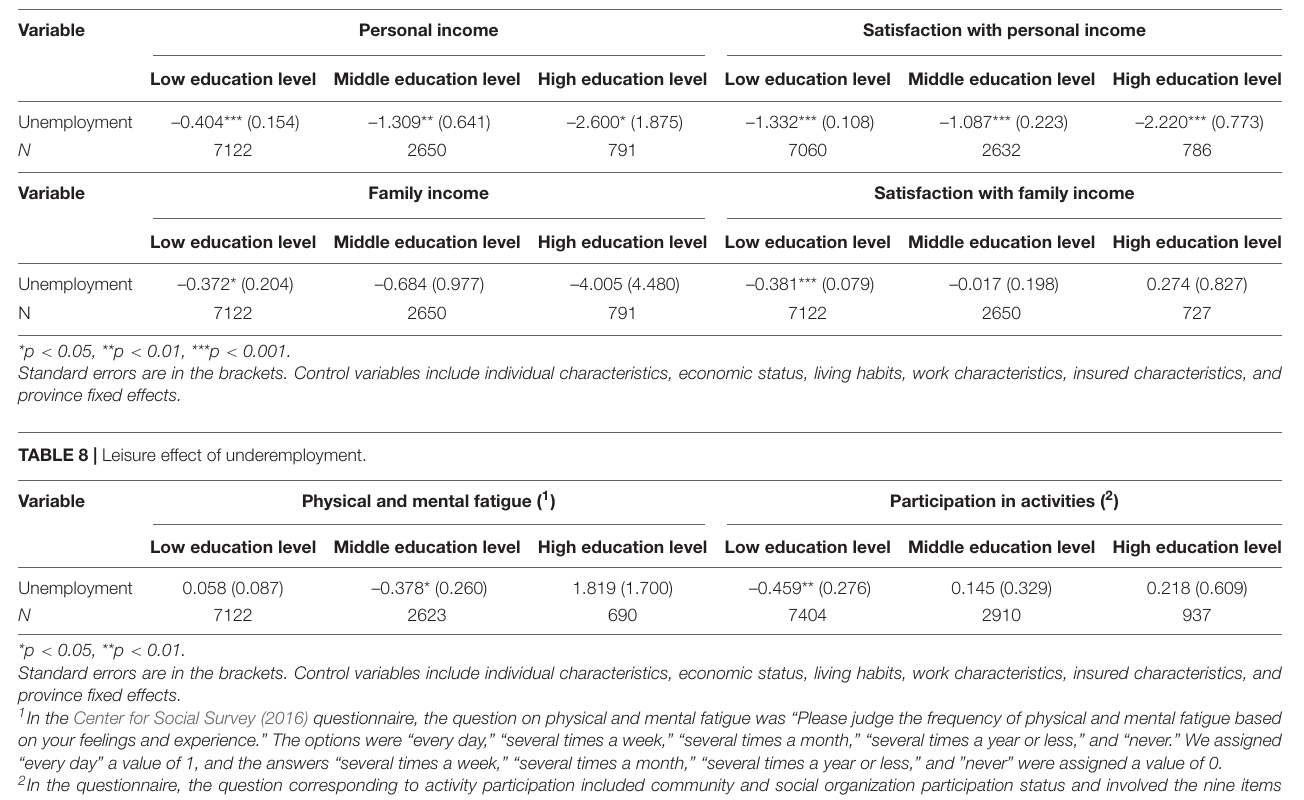
TABLE 7 | Economic effects of underemployment.